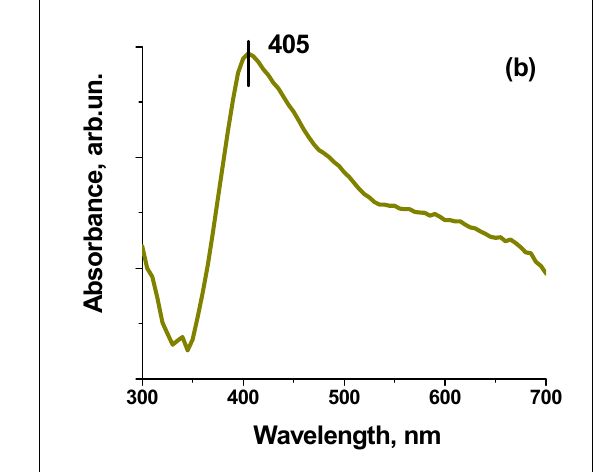
Table 1. TEM and XRD data for supported silver nanoparticles and DLS data for silver-contained sols, which are prepared by the STS technique from supported silver catalysts.